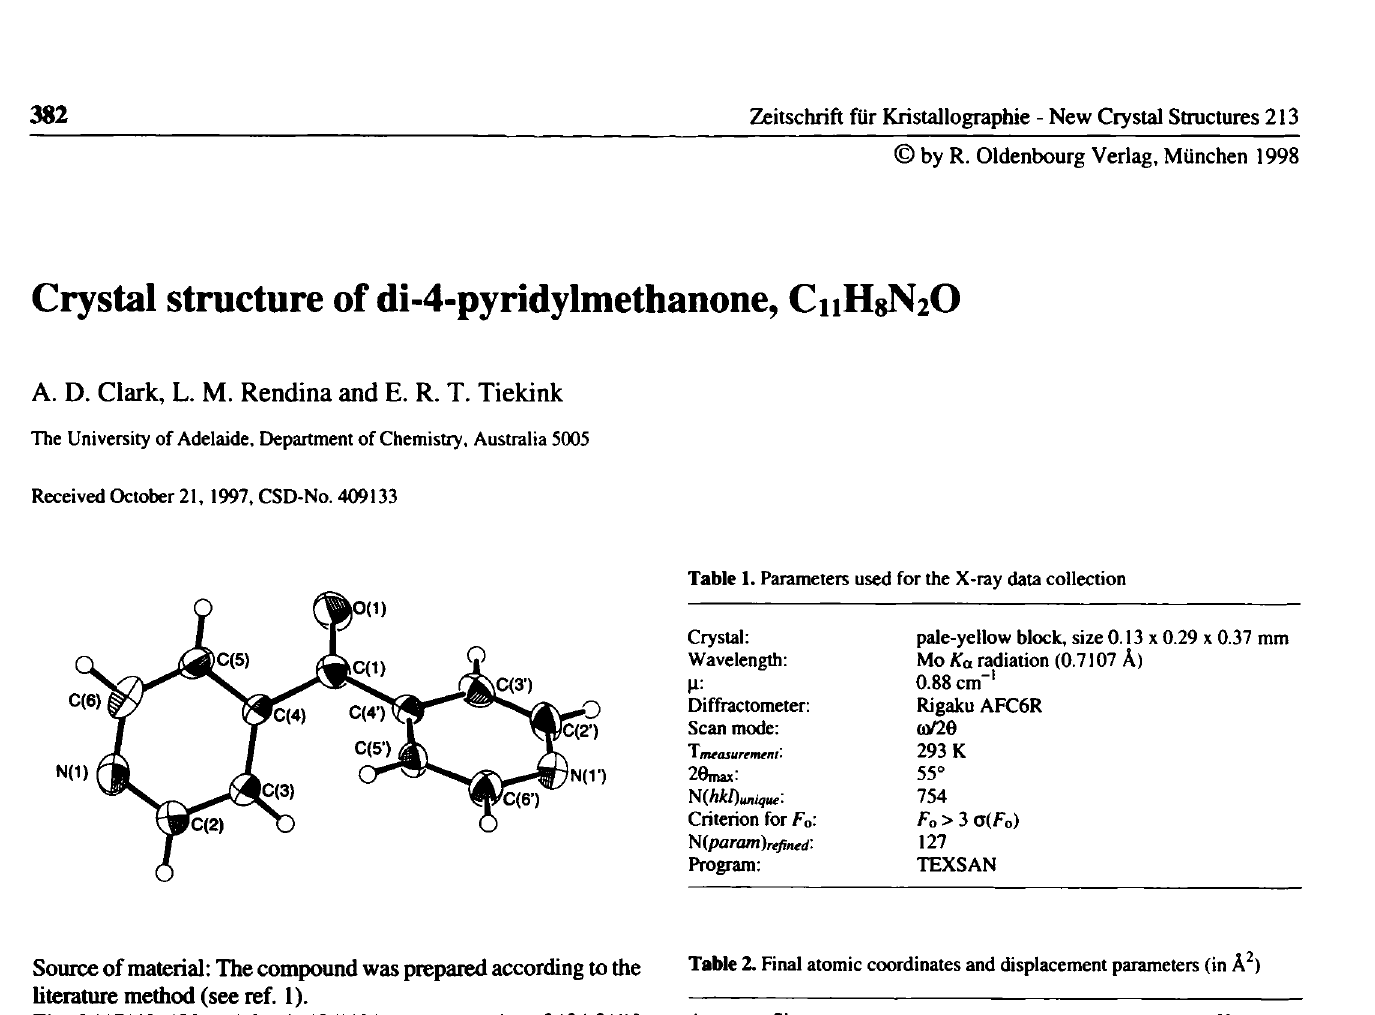
Table 2. Final atomic coordinates and displacement parameters (in